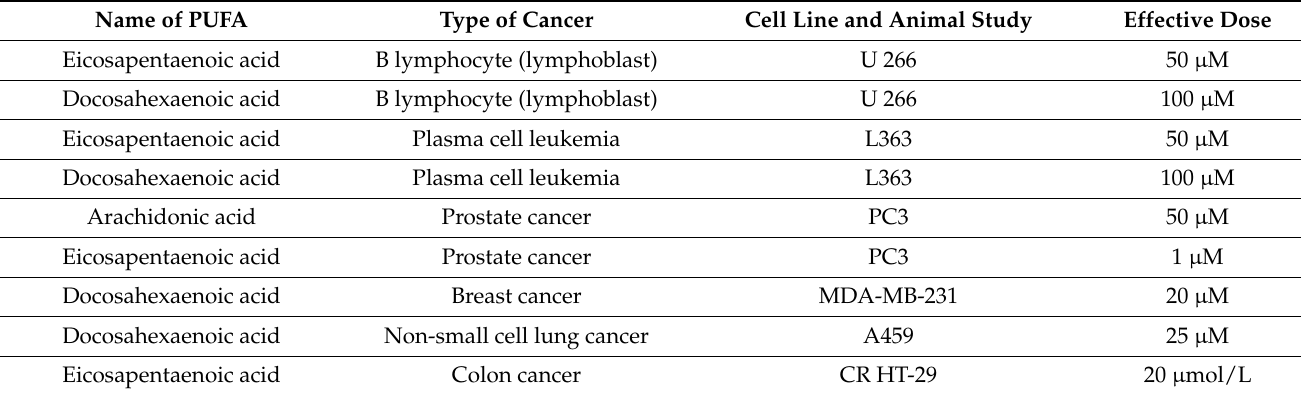
Table 2. Contribution of different omega-3 PUFAs for the prevention of different